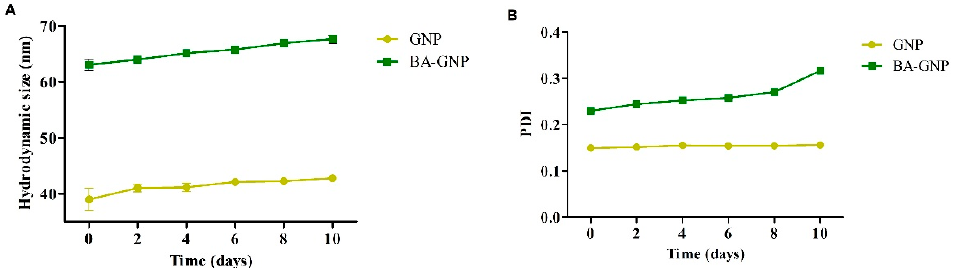
Figure 5. Time course changes of GNP and BA-GNP in ( A ) hydrodynamic size and ( B ) polydispersity index (PDI) stored at room temperature for a 10-day period.